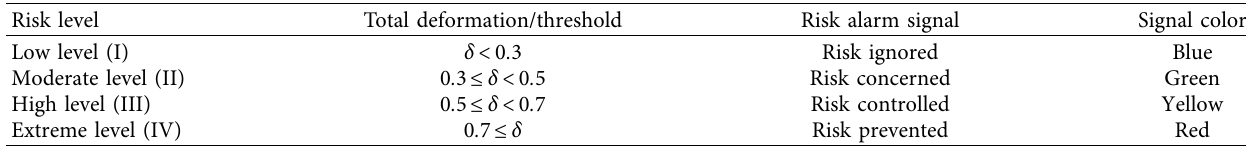
Figure 2: Operation mechanism of the real-time prediction model for metro tunnel deformation. Table 2: Security risk classification and alarm signal